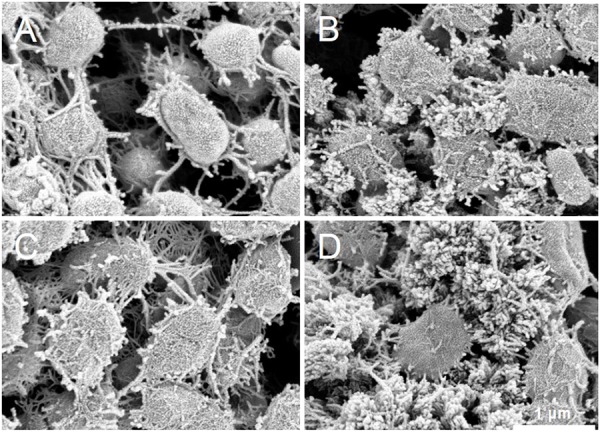
Scanning electron microscopy (SEM) images of biofilm established on porous carbon felt by strain S05 when cultured with (A) electrode, (B) oxygen, (C) nitrate, and (D) none as external electron acceptor, respectively (sufficient supply).